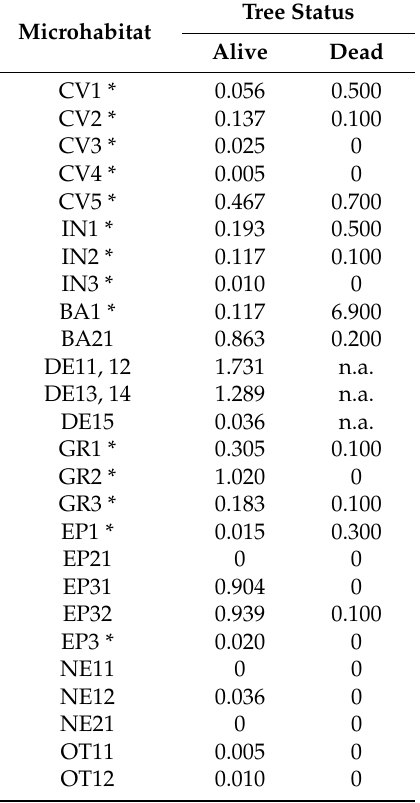
Table A4. Microhabitat frequencies for living and dead Abies alba habitat trees. For microhabitat codes, see Table